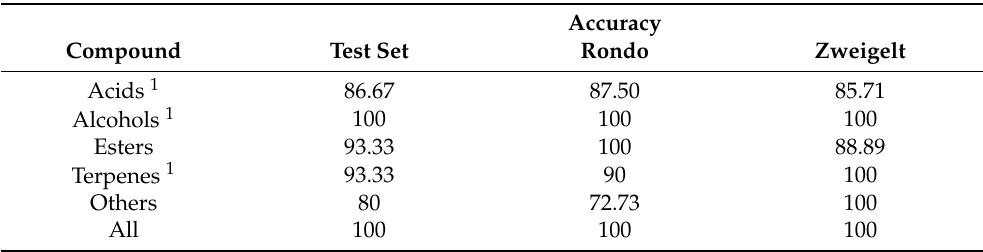
Table 3. Classification accuracy of kNN method in the test set and in the subsets of Rondo and Zweigelt wines